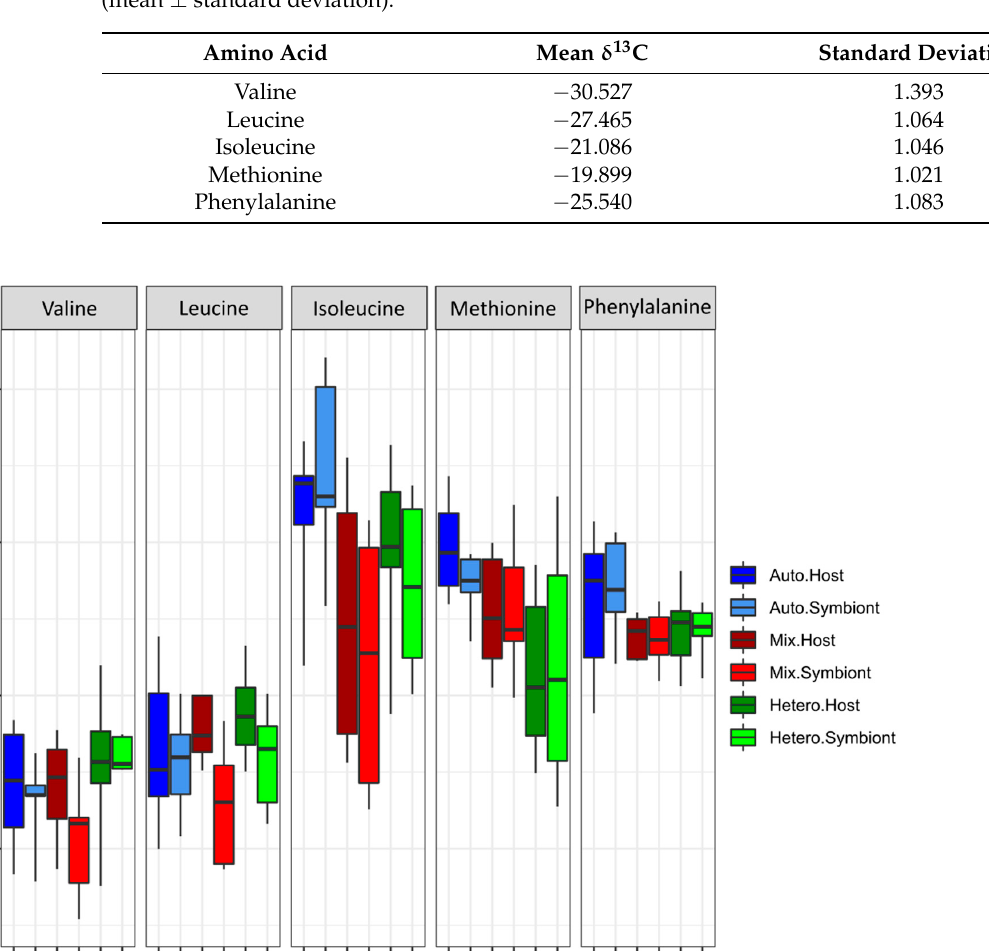
Table 1. The δ 13 C values of the essential amino acids contained in the Artemia salina prey